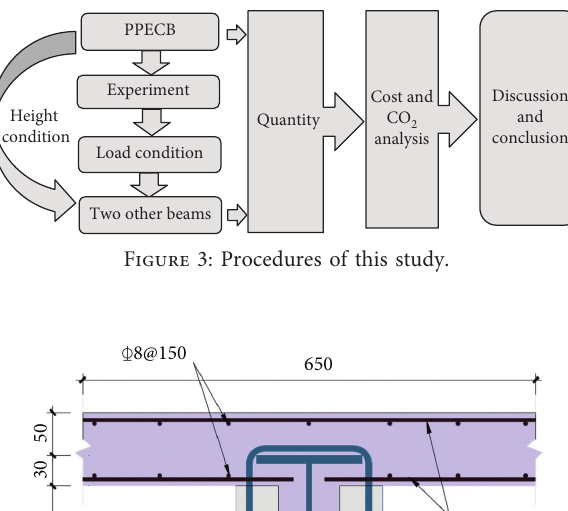
Figure 6: Failure mode of the PPEC beam.